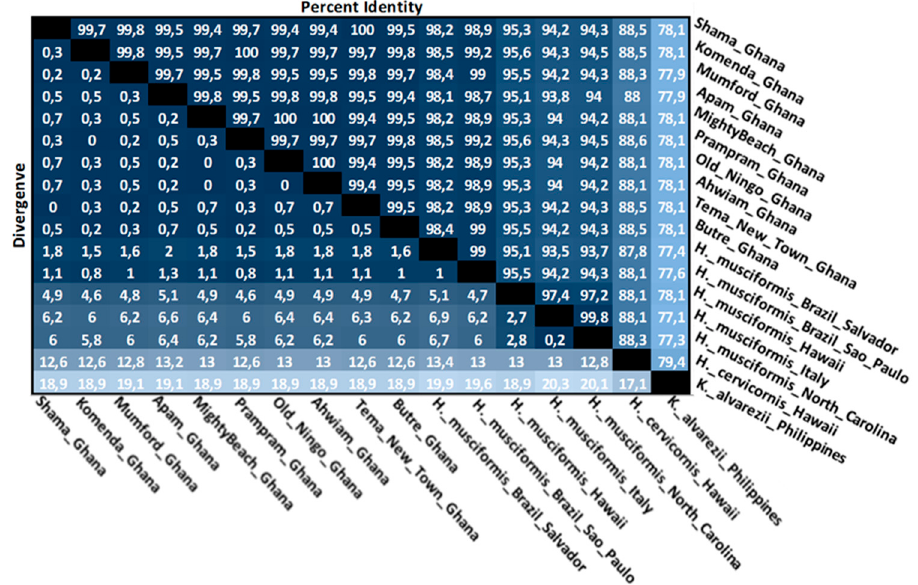
Figure 4. Divergences and identities of COI barcode sequences from Ghanaian Hypnea sp. together with references from the NCBI GenBank H. musciformis , H. cervicornis and Kappaphycus alvarezii . The intensity of the blue color increases as the divergences decreases and the identity percentages increase relative to the sequences of this work.